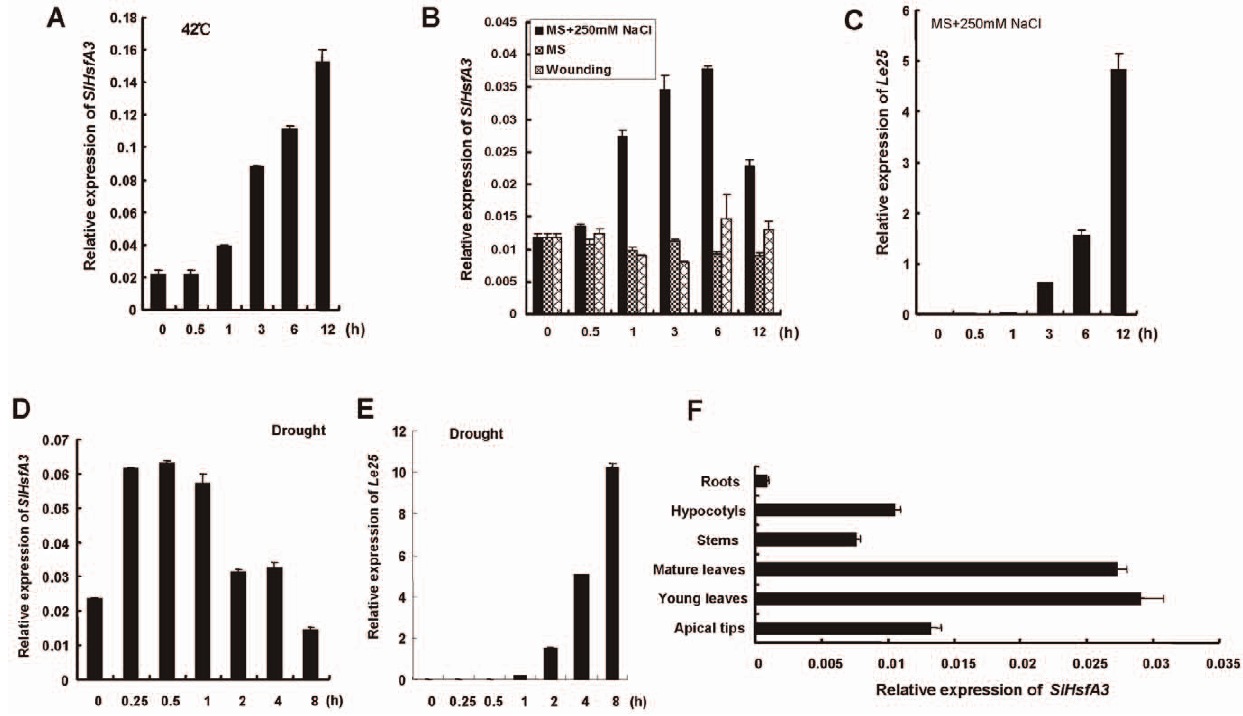
Figure 2. mRNA expression patterns of SlHsfA3 in response to various abiotic stresses. (A) High temperature-induced expression pattern of SlHsfA3 in tomato plants. Four-week-old tomato seedlings, grown under standard conditions, were placed in a climate chamber set at 42 u C for 12 h. The aerial parts were harvested at the indicated times for RNA extraction and qRT-PCR analysis. Zero time samples were taken prior to treatment. Transcript levels of SlHsfA3 were normalized to the ACTIN2 expression. (B–E) High salinity and drought-induced expression patterns of SlHsfA3 in tomato. Three-week-old tomato seedlings, grown under standard conditions, were used for stress treatments. The SlHsfA3 mRNA levels were analyzed as in (A) and the Le25 [67,68] tomato gene was used as a positive control for high salinity and drought treatments. (F) Basal mRNA levels of SlHsfA3 were quantified by qRT-PCR as described in (A) in different organs of tomato plants (n=10). All stress treatments were initiated at the beginning of the 16 h light period (28 u C) to ensure identical environmental conditions throughout the time course. Data shown are average and SD of triplicate reactions. Shown are representative data from one biological replicate and we conducted three biological replicates with similar results.